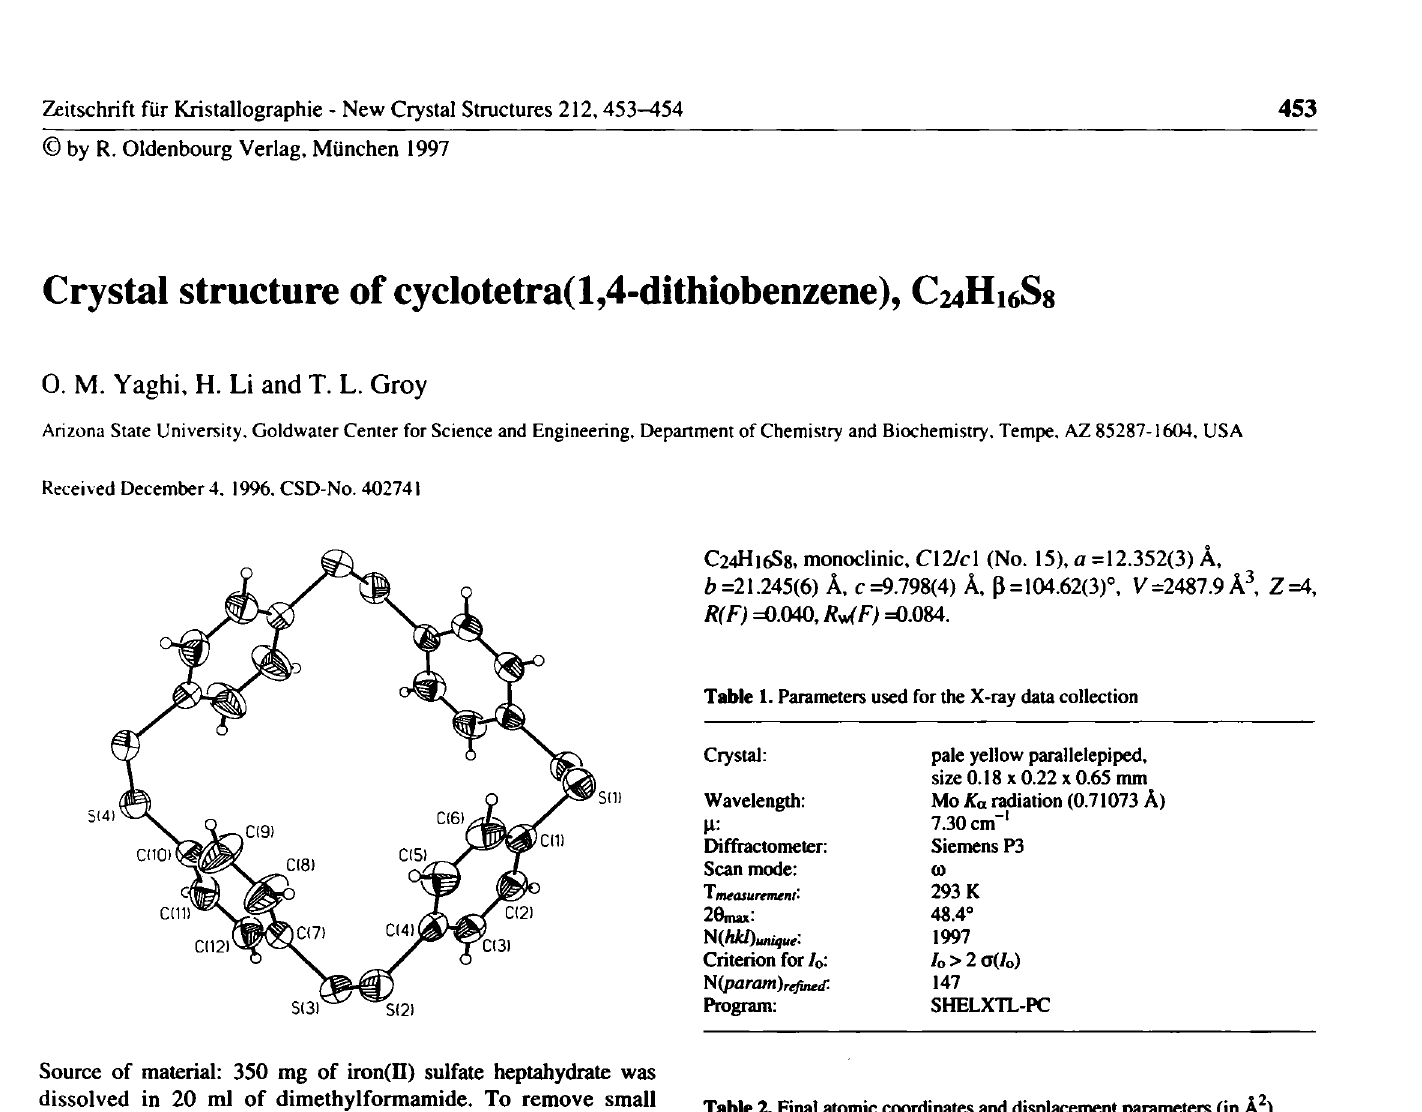
Table 3. Final atomic coordinates and displacement parameters (in Â 2 )